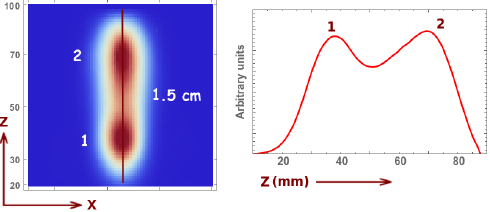
Figure 6. Image reconstruction (five iterations and three sub-iterations) and profile for a two-sphere phantom with 1.5 cm diameter and 3.0 cm distance in between their centers, 1 min acquisition time and 0.1 Mbq activity (of each sphere). The distance in z stands for the distance from the collimator (see reference system defined in Figure 2).